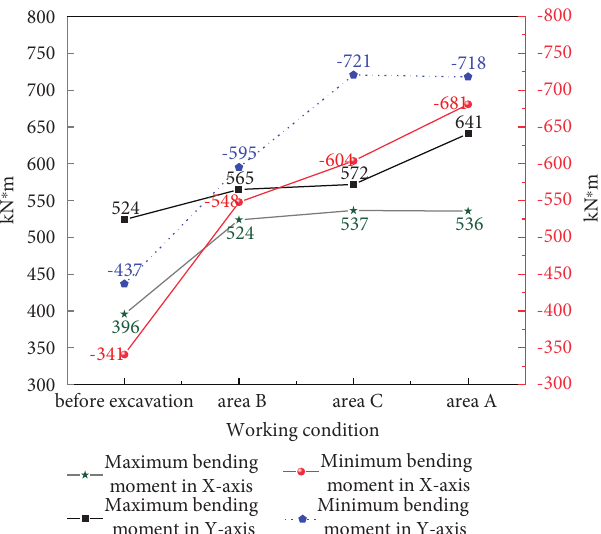
Figure 10: Maximum bending moment of the common diaphragm wall from the foundation pit excavation to the pit bottom.